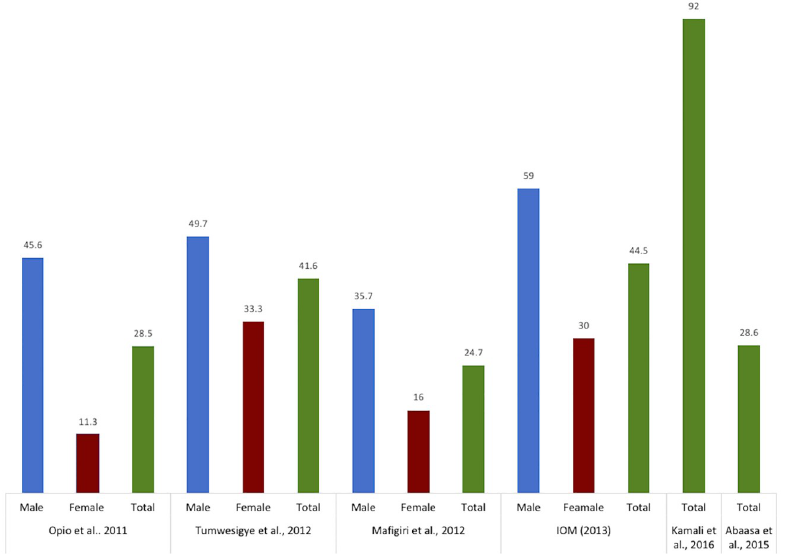
Fig 7. Multiple sexual partnership in selected studies. IOM: International Organization for Migration. Kamali et al. (2015): more than 2 partners in the past 12 months. Abaasa et al. (2015): more than 2 partners (no time line provided). The numbers represent the prevalence reported as percentage